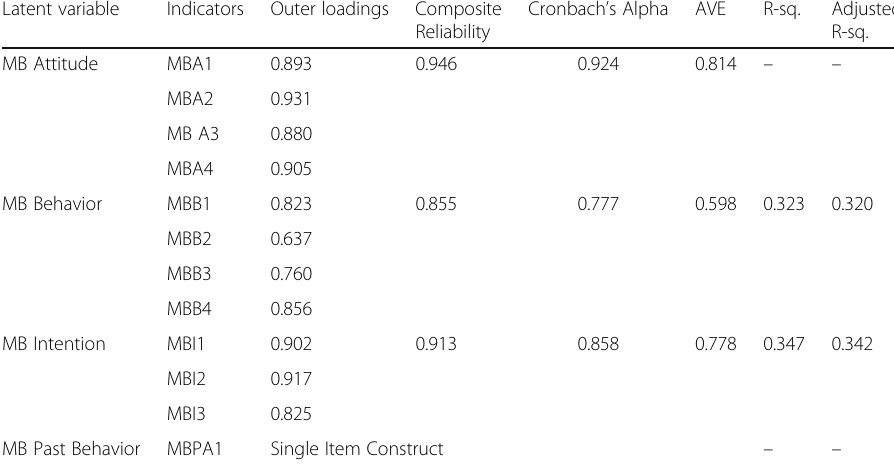
Table 3 Values of outer loadings, CR, Cronbach alpha, AYE, R square and adjusted R square Latent